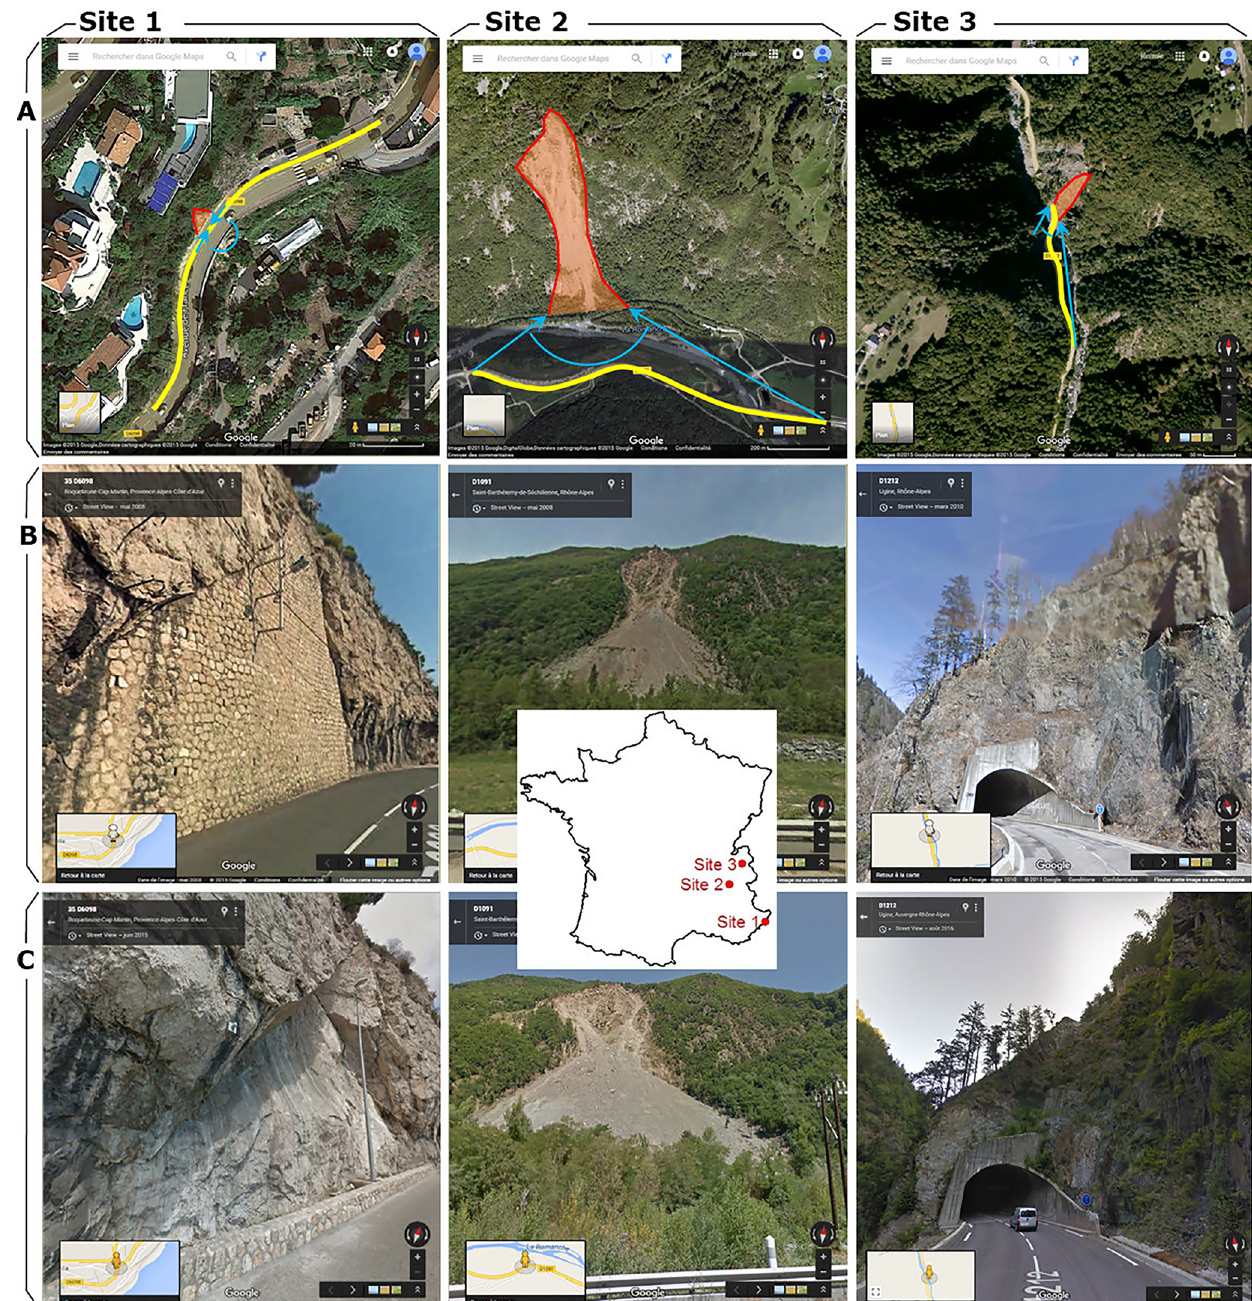
Figure 2. The three French sites (1: Basse Corniche; 2: Séchilienne; 3: Arly gorges). (a) Google Maps aerial view of the sites (in red) with the road path (yellow) used to take the GSV images of the scenes and the view angle (blue) of the images point of view around the sites. (b) First GSV of the sites. (c) Last GSV of the